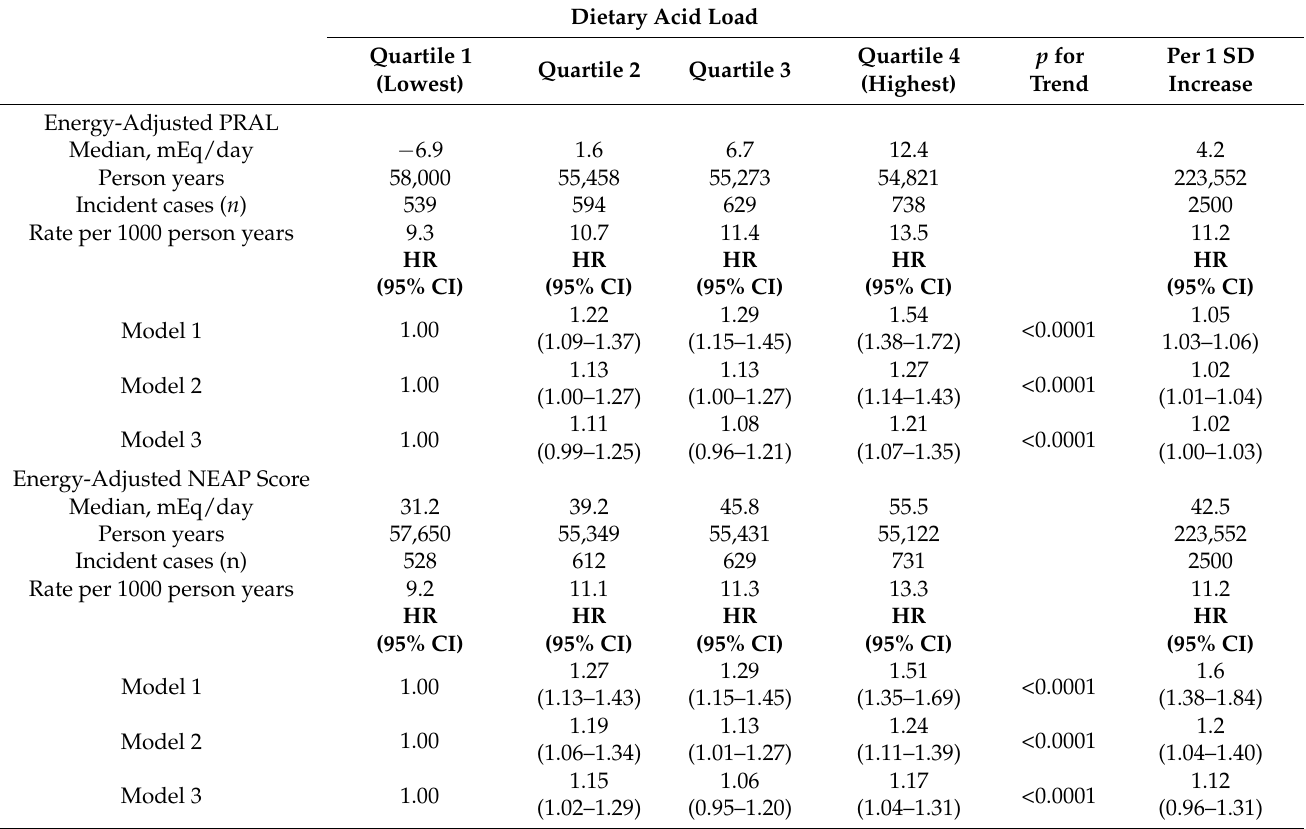
Table 3. HRs (95% CIs) for hyperuricemia according to the dietary acid load based on the PRAL and NEAP scores. Dietary Acid